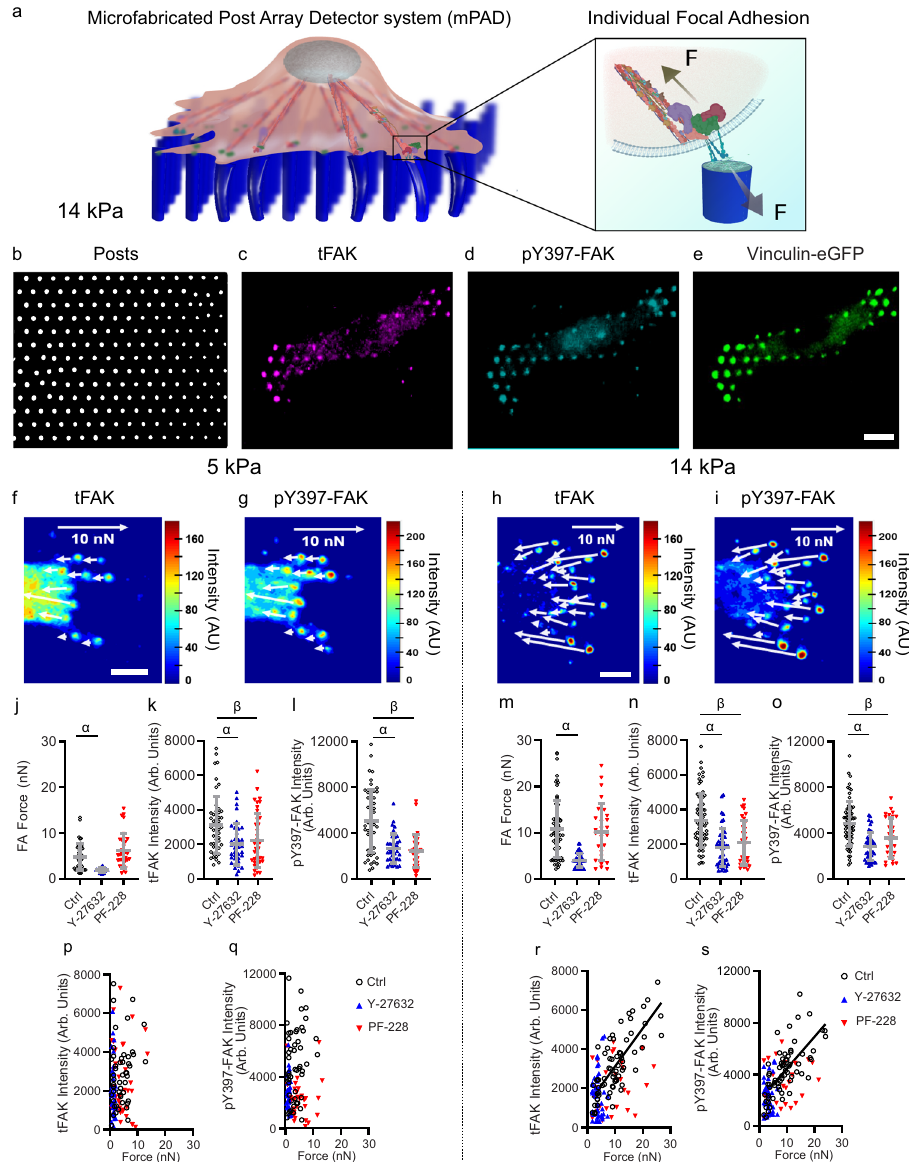
Fig. 1 Force-FAK localization and force-pY397-FAK are linearly coupled at individual FAs. a Schematic of individual FA traction force measurement for a cell using mPADs. Fluorescence images showing ( b ) mPAD posts, ( c ) tFAK, ( d ) pY397-FAK, and ( e ) eGFP-vinculin for cell on mPAD. f – i Heatmaps for ( f , h ) tFAK and ( g , i ) pY397-FAK staining at FAs on mPADs of 5 or 14kPa. White arrows indicate force magnitudes and directions. Scale bar 5 µ m. j Force (mean ±SD) at individual FAs on 5kPa mPADs. Two-sided Kruskal-Wallis test P <0.0001, α : P <0.0001, n = 50, 36, 33 FAs for each condition, respectively. k tFAK integrated intensity (mean±SD) at FAs on 5kPa mPADs. ANOVA P <0.0001, α : P = 0.0032, β : P = 0.0195, n = 49, 37, 33 FAs for each condition, respectively. l pY397-FAK integrated intensity (mean±SD) at individual FAs on 5kPa mPADs. Two-sided Kruskal-Wallis test P <0.0001, α : P = 0.0002, β : P <0.0001, n = 50, 36, 33 FAs for each condition, respectively. m Force (mean±SD) at individual FAs on 14kPa mPADs. Two-sided Kruskal-Wallis test P <0.0001, α : P <0.0001, n = 66, 48, 28 FAs for each condition, respectively. n tFAK integrated intensity (mean±SD) at FAs on 14kPa mPADs. ANOVA P <0.0001, α : P <0.0001, β : P = 0.0004, n = 66, 48, 33 FAs for each condition, respectively. o , pY397-FAK integrated intensity (mean±SD) at individual FAs on 14kPa mPADs. Two-sided Kruskal-Wallis test P <0.0001, α : P <0.0001, β : P <0.0146, n = 66, 46, 28 FAs for each condition, respectively. p Force vs. tFAK intensity at individual FAs on 5kPa. Linear regression: control P = 0.1230, n = 50 FAs; Y-27632 P = 0.1920, n = 37 FAs; PF-228 P = 0.9869, n = 38 FAs. q , Force vs. pY397- FAK intensity at individual FAs on 5kPa. Linear regression: control P = 0.1072, n = 50 FAs; Y-27632 P = 0.2937, n = 36 FAs; PF-228 P = 0.8874, n = 33 FAs. r Force vs. tFAK intensity at individual FAs on 14kPa. Linear regression: control P <0.0001, n = 66 FAs, tFAK intensity = 194.6×force + 1178; Y-27632 P = 0.8896, n = 48 FAs; PF-228 P = 0.2084, n = 28 FAs. s Force vs. pY397-FAK intensity at individual FAs on 14kPa. Linear regression: control P <0.0001, n = 66 FAs, pY397-FAK intensity = 219.7×force + 2027; Y-27632 P = 0.7986, n = 46 FAs; PF-228 P = 0.2260, n = 26 FAs. binding mutant ( P = 0.0005). Cells expressing WT and E1015A examined the relationship between traction force and tFAK, as well exhibit equivalent average levels of pY397-FAK, whereas cells as traction force and pY397-FAK at individual FAs. Consistent with expressing the K454R and Y397F phosphorylation mutant display results for wild-type MEFs (Fig. 1r, s), WT FAK-expressing FAK- very low levels of pY397 staining (Supplementary Fig. 9). We null cells exhibit force-tFAK and force-pY397-FAK linear NATURE COMMUNICATIONS| (2021) 12:2359